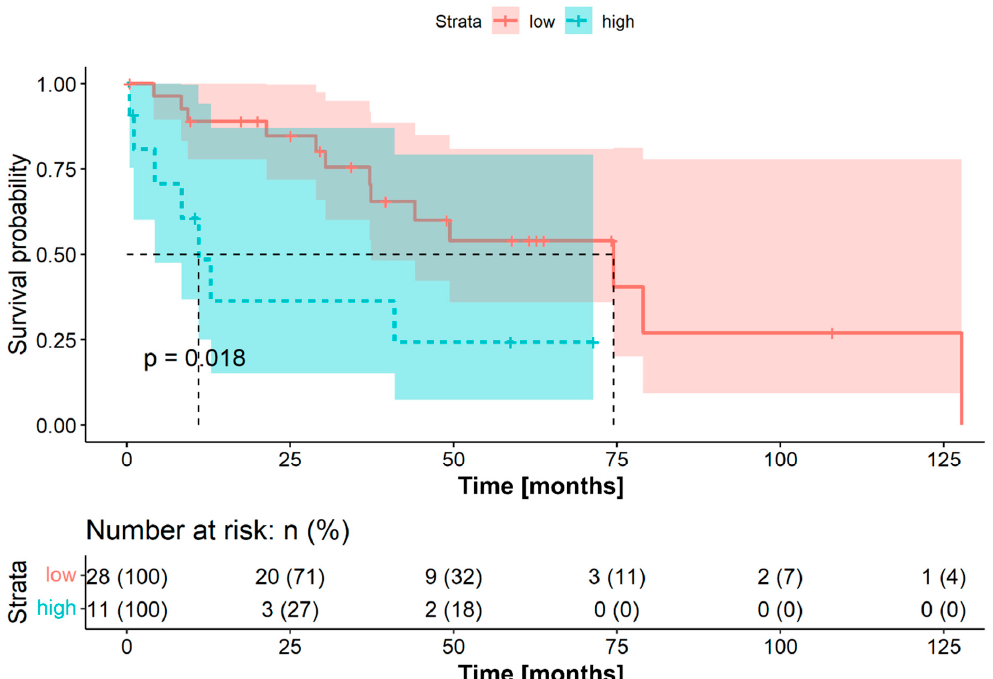
Figure 2. Disease-free survival for patients with adenoid-cystic carcinoma stratified into a low ( n = 28) and a high group ( n = 11) according to the optimal threshold for fibrinogen-to-lymphocyte ratio for overall survival (272.9.). The corresponding brighter colored areas represent the 95% confidence intervals. The survival times were statistically significantly different between patients with low and high fibrinogen-to-lymphocyte ratios (log-rank test p =